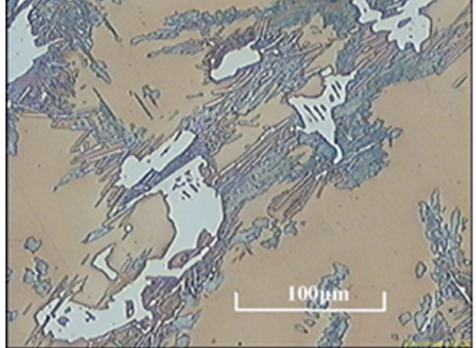
Figure 2. As-cast microstructure of Hadfield steel with the addition of chromium (1.4%); austenitic matrix with precipitates of lamellar alloyed cementite; Nital etching, [4]. Solution heat treatment of castings made from alloys with increased chromium content does not guarantee obtaining a purely austenitic structure. It is also doubtful if this structure could be obtained by other measures applied, such as higher austenitizing temperature and longer time of this treatment [4]. Figure 3 shows an example of the microstructure of Hadfield cast steel with the addition of 1.4% Cr, where after solution heat treatment at 1200 ◦ C and annealing for 80 min, an austenitic matrix with undissolved carbides at the grain boundaries was obtained. In his own unpublished study, the author has demonstrated that the addition of chromium in an amount of 1.4% causes in the Miller test a two times lower weight loss of the tested samples compared to Hadfield cast steel with typical chemical composition subjected to standard heat treatment. The wide use of Hadfield cast steel in industry drives the constant search for modifications of its properties through changes in the chemical composition. For example, the research described in [5,6] shows changes in the microstructure and abrasive wear resistance in the Miller test of Hadfield cast steel with the addition of 5.5% V. Owing to the change in chemical composition, in the solution heat-treated test castings, an austenitic matrix with faceted vanadium carbides evenly distributed in this matrix was obtained. Figure 4 shows the microstructure of this alloy. The uniform distribution of vanadium carbides in the alloy matrix improves the abrasive wear resistance in the Miller test at least two times in the as-cast condition and three times after solution heat treatment. Figure 5 compares the abrasive wear response of Hadfield cast steel in the as-cast condition and after solution heat treatment with that of high-manganese cast steel containing 5.5%